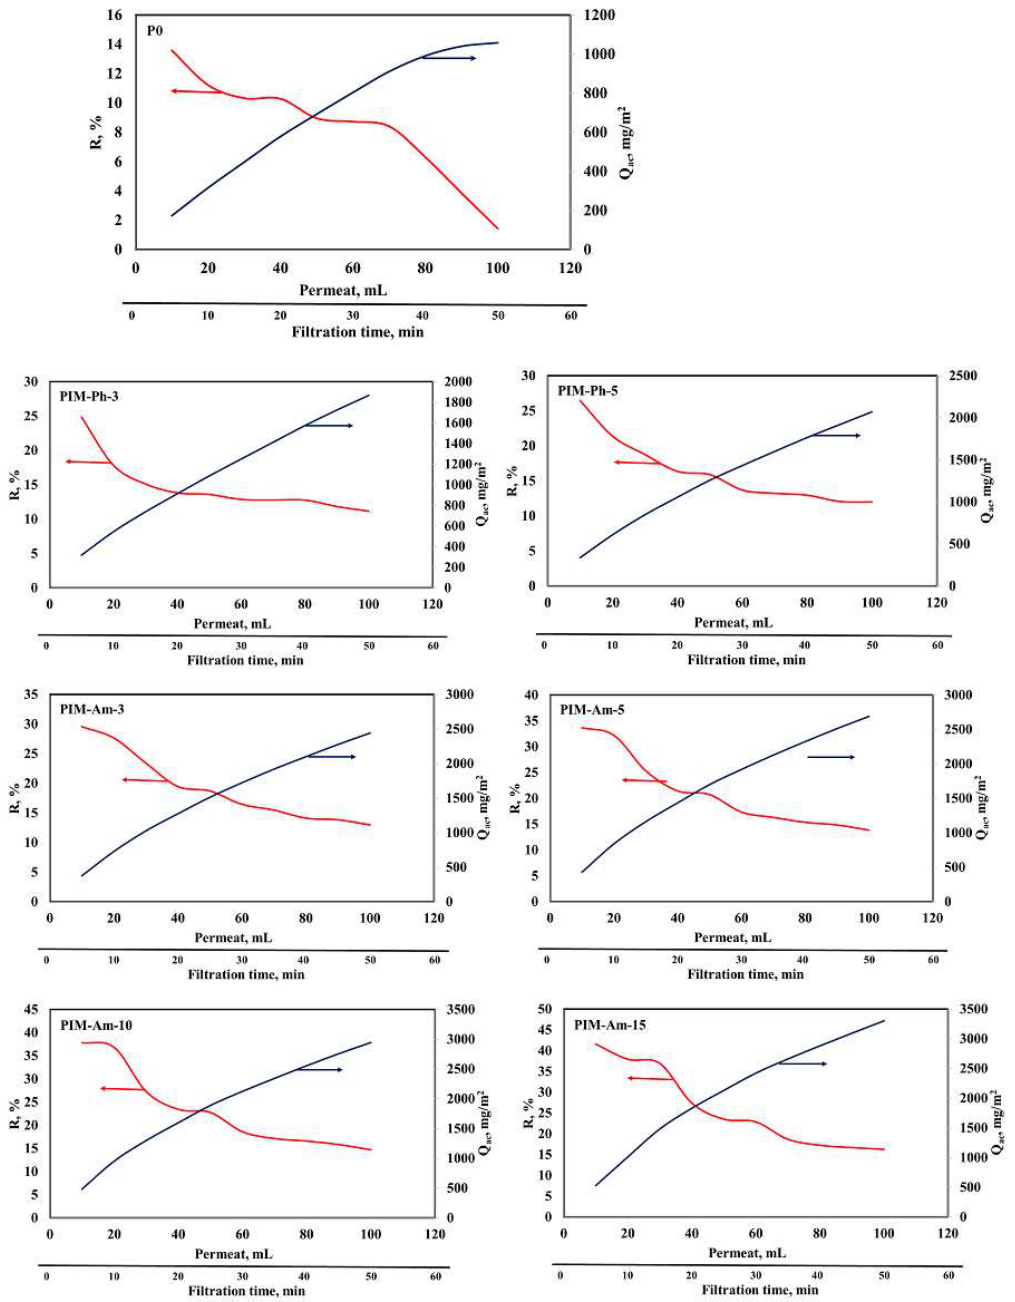
Figure 6. Dependence of the removal degree (red lines) and the amount of Cd(II) accumulated in the membrane (blue lines) as a function of the treatment time and the permeate volume.